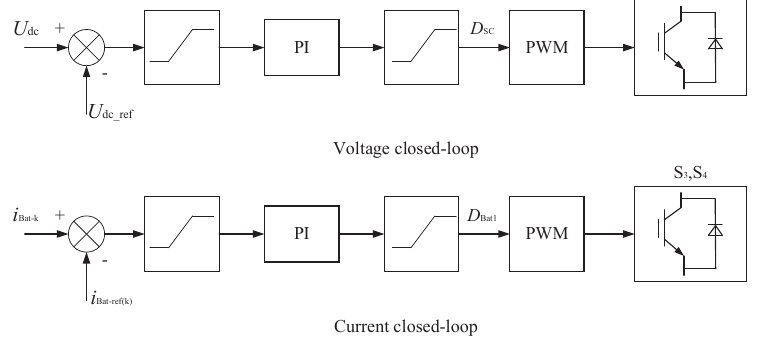
Figure 3. The voltage closed-loop and the current closed-loop of HESS converter.